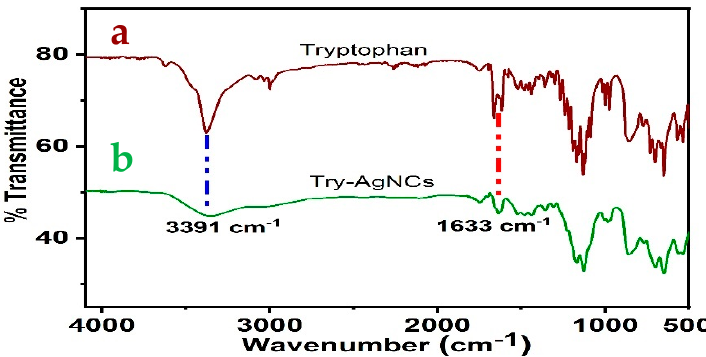
Figure 3. ( a ) FTIR spectra of tryptophan; ( b ) Tryp-AgNCs.